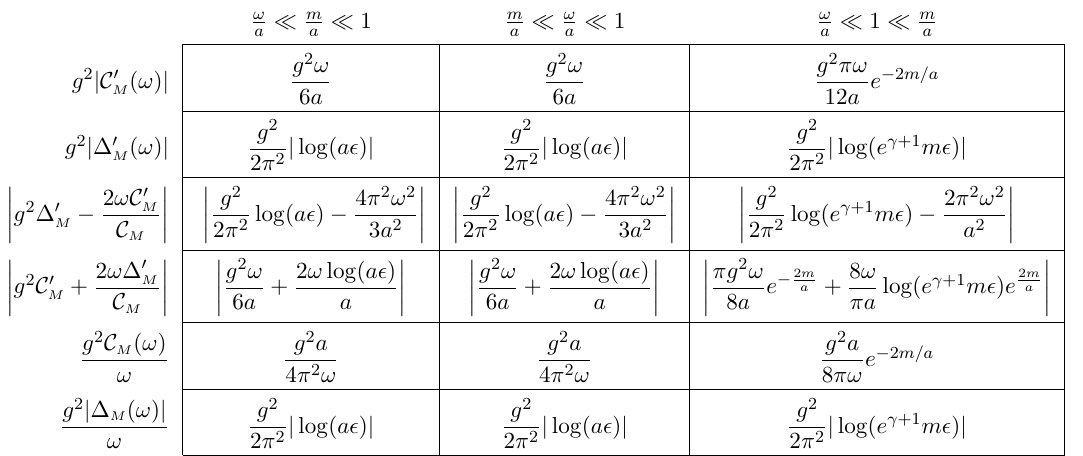
Table 2 . Asymptotic form for the quantities that must be small if the Markovian approximation is to be good, in various regimes for the relative sizes of ! , m and a . Only ! (cid:28) a is considered because the rightmost three columns of table 1 show that all Markovian conditions cannot be satis(cid:12)ed unless this is true. The (cid:12)rst four rows express conditions (4.31) and (4.32), while the bottom two rows are assumptions about the regime for ! that are assumed when deriving the top four rows.